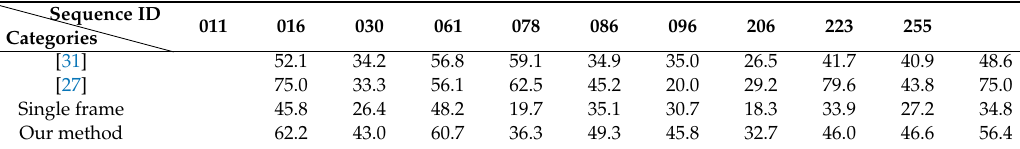
Table 2. Comparative experiments on 10 sequences of SceneNN dataset (units: